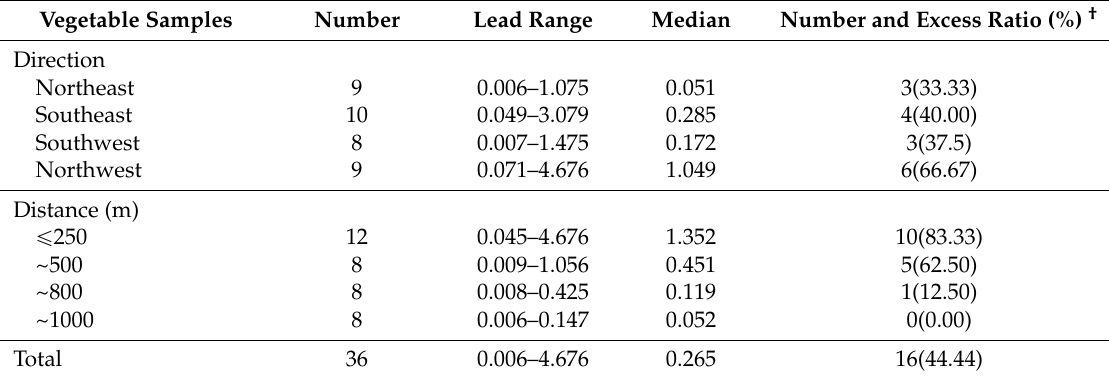
Table 6. The results of vegetable samples (mg/kg).